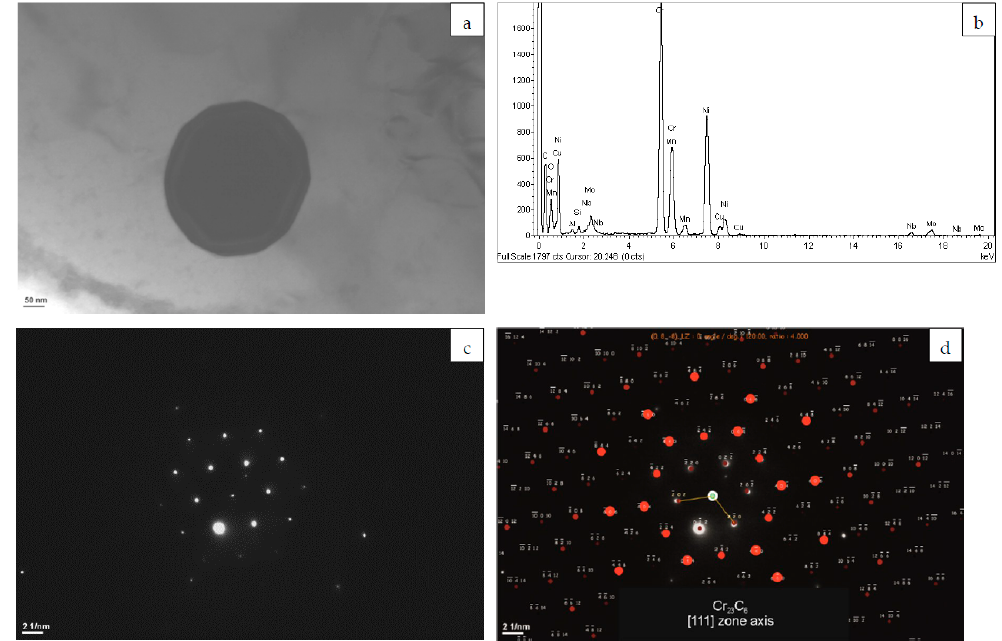
Figure 5. ( a ) TEM image of the M 23 C 6 precipitate; ( b ) the corresponding EDS spectrum; ( c ) SAED pattern; and ( d ) its solution for Cr 23 C 6 [111] zone axis.